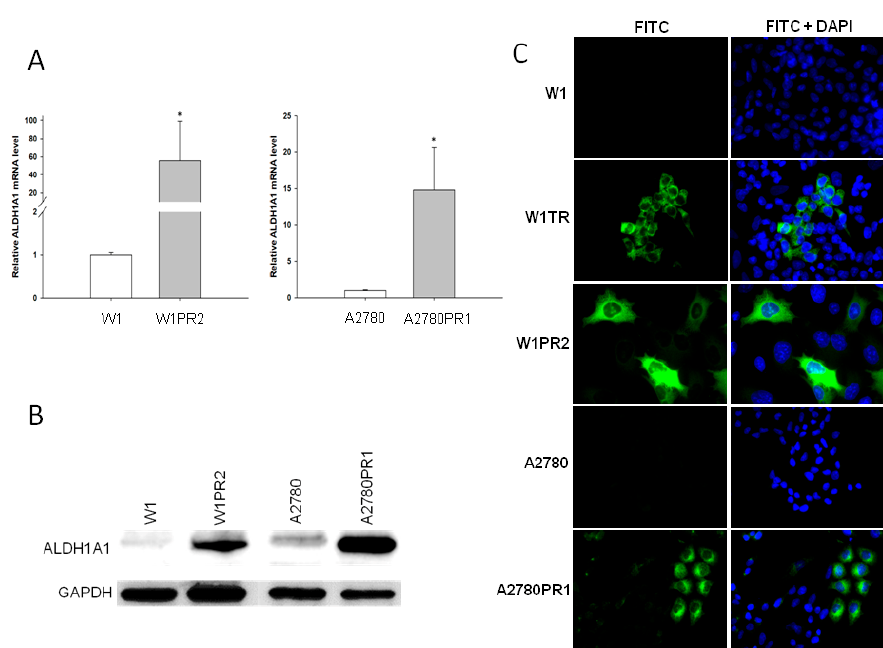
Figure 3. Expression analysis of ( A ) ALDH1A1 transcript (Q-PCR) in the W1, A2780, and their sublines resistant to PAC. The figure presents the relative gene expression in the resistant cell lines (gray bars) with respect to that in the sensitive cell line (white bars), which has been assigned a value of 1. The values were considered significant at * p < 0.05. ( B ) ALDH1A1 protein expression analysis in the W1, A2780, and their sublines resistant to PAC. The cellular proteins were separated using 7% PAGE and transferred to a PVDF membrane, which was then immunoblotted with either primary Ab or HRP-conjugated secondary Ab. A primary anti-GADPH Ab was used as a loading control for the cell lysates. ( C ) ALDH1A1 immunofluorescence in the W1 and A2780 drug-resistant cell sublines. ALDH1A1 was detected using the anti-ALDH1A1 antibody and Alexa Fluor ® 488-conjugated secondary antibody (green). To visualize the cell nuclei, the cells were mounted with a DAPI-containing mounting medium (blue). Objective 40×.